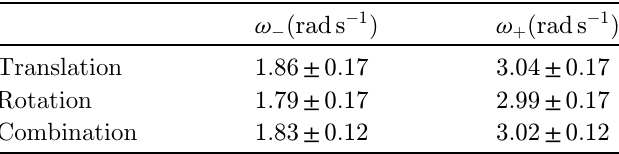
Table 2. Values of v (cid:1) and v analysis of the experimental curves.